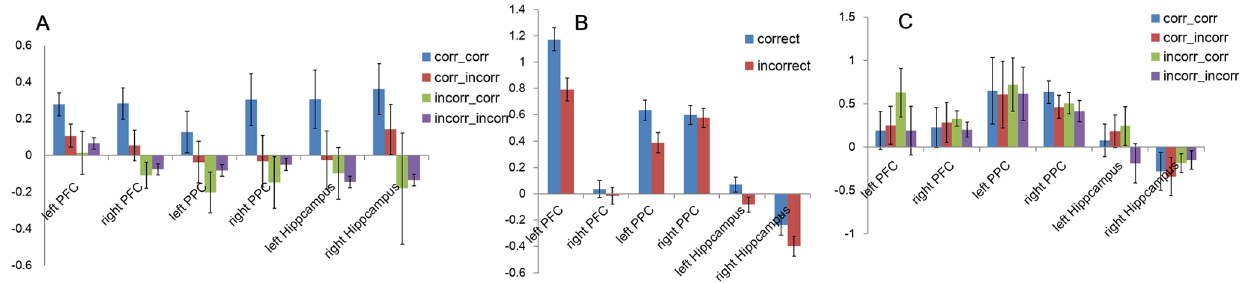
Figure 2. Subsequent Memory Effects. A. Parameter estimates (beta values) of ROIs for Test 1 trials as a function of accuracy on Test 1 (left term in legend) and Test 2 (right term in legend). B. Parameter estimates of ROIs for initial study phase as a function of accuracy on Test 1. C. Parameter estimates for ROIs in Re-study 1 (study following Test 1) as a function of accuracy on Test 1 (left term in X-axis labels) and Test 2 (right term in X-axis labels). Error bars are 6 1 standard error.